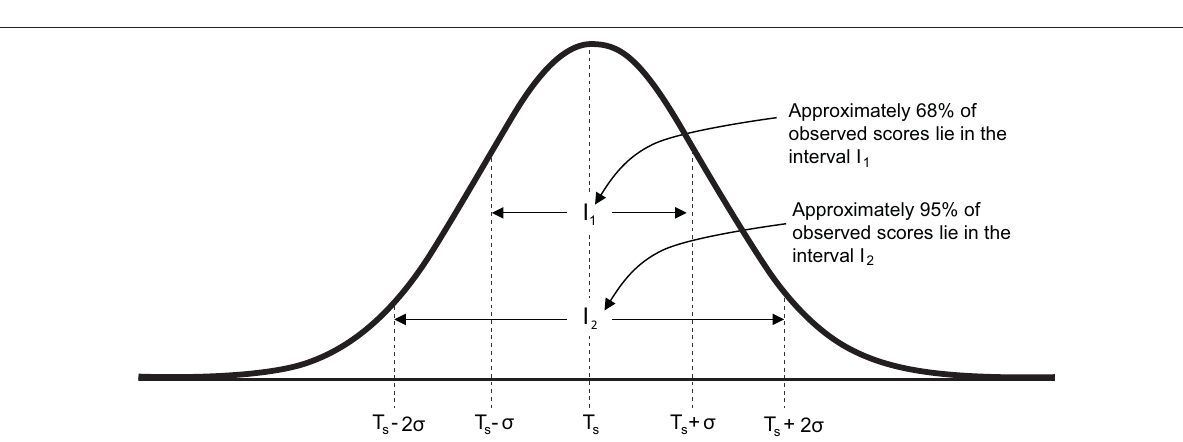
FIGURE 1 | Schematic of hypothetical study design. CCT 110 % , High-intensity cycling capacity test; B-A, Beta-alanine supplementation; PLA, Placebo.